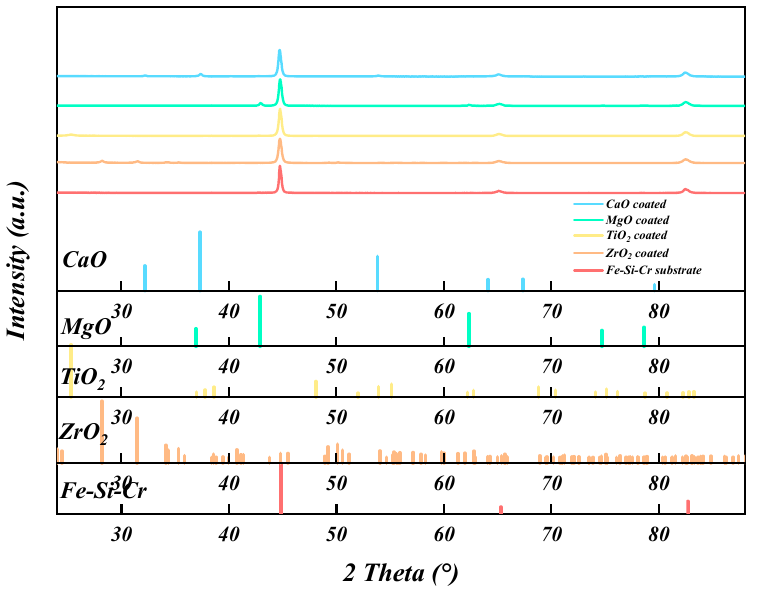
Figure 1. XRD spectra of raw Fe-Si-Cr alloy powder and Fe-Si-Cr/AO x composite powders compris- ing varying metal oxide insulating